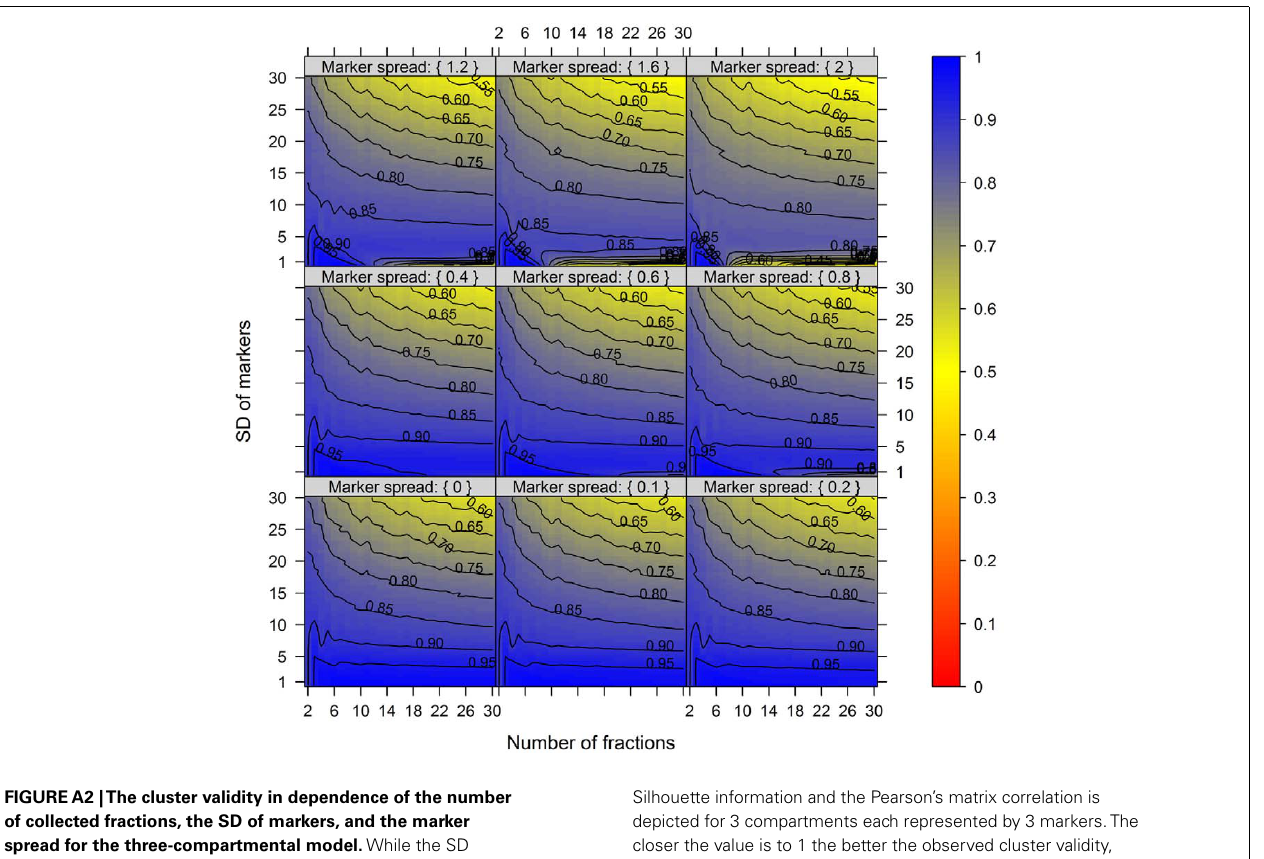
FIGUREA2 |The cluster validity in dependence of the number of collected fractions, the SD of markers, and the marker spread for the three-compartmental model. While the SD modulates the between-compartmental separation, the marker spread modulates the within-compartmental cohesion (cf. Figure 3).The cluster validity index estimated as mean–average of the